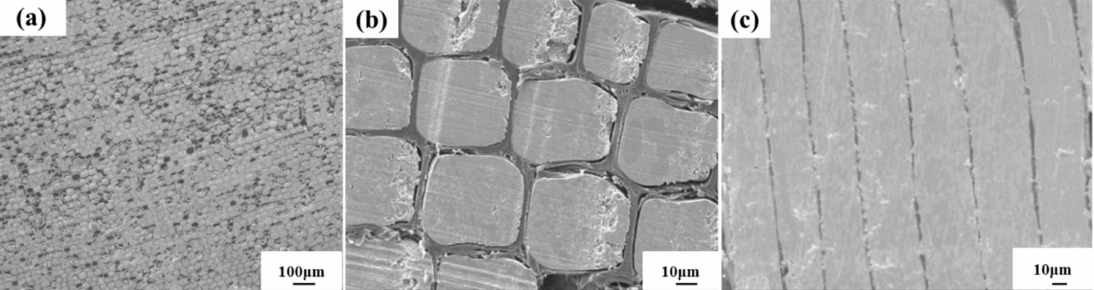
Figure 1. SEM images of wood-metal functional composites: ( a , b ) cross-section of sample and ( c ) tangential section of